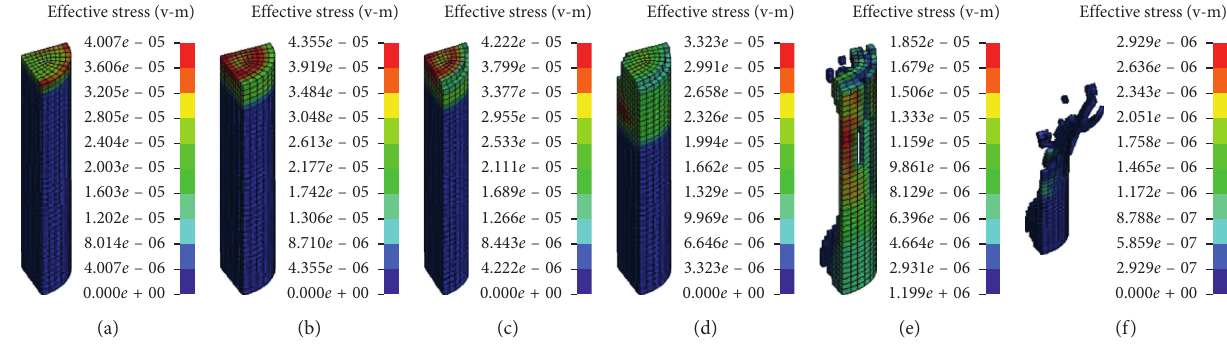
Figure 3: The effective stress distribution at an impact velocity of 6m/s. (a) 2 μ s. (b) 6 μ s. (c) 7 μ s. (d) 18 μ s. (e) 72 μ s. (f) 5000 μ s.